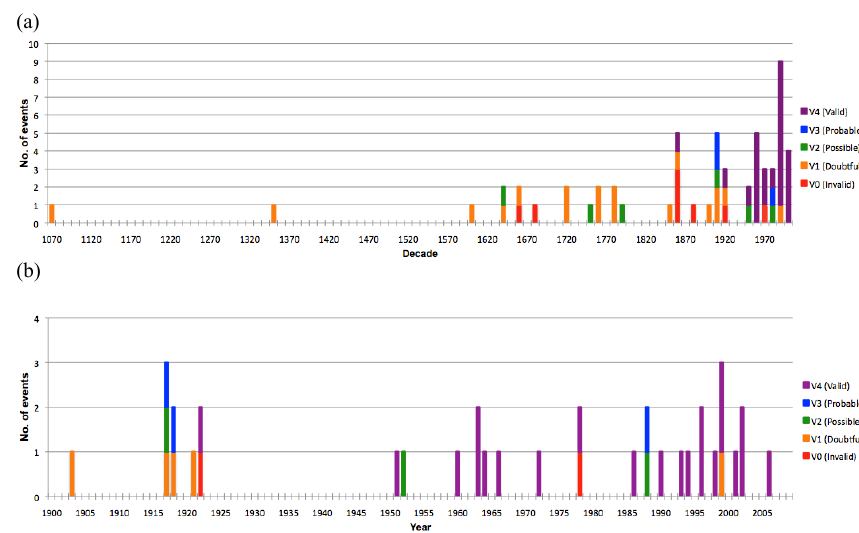
Fig. 2. Temporal distribution of reported historical tsunamis, with assigned validity scores, in the NE SCS region. More valid tsunamis are reported since 1950s as tide gauge stations are available to show sea level changes. (a) All historical events reported in the region, covering since AD1076. Horizontal axis is in decade starting AD1070. (b) Distribution of reported historical tsunamis from AD1900–2009 given in